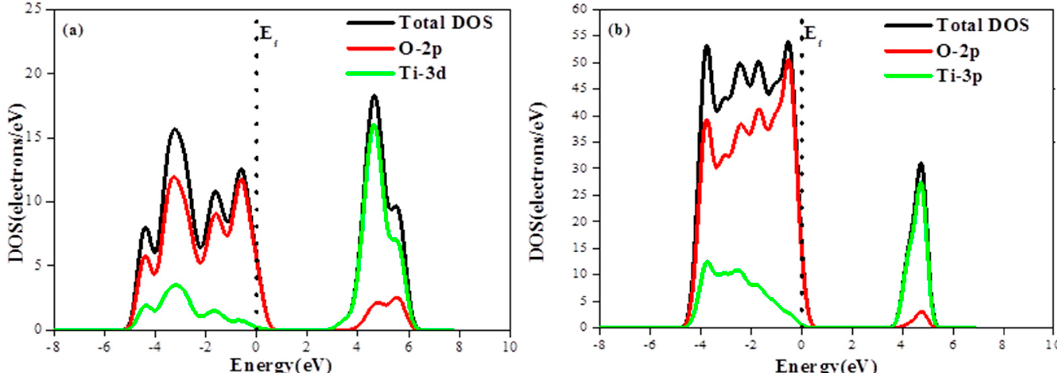
Figure 3. ( a ) Density of states of primitive TiO 2 and partial DOS of O, Ti atom; and ( b ) the density of states of the anatase TiO 2 (101) plane and partial DOS of O, Ti atom.